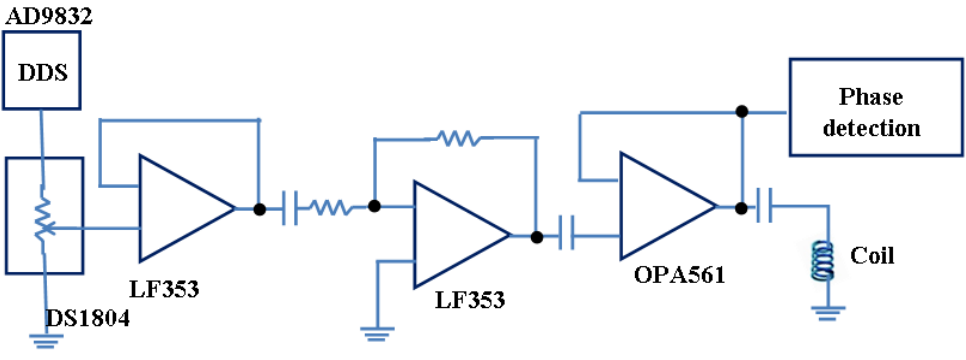
Figure 10. A schematic representation of the AC biasing circuit the block-diagram of which is shown in Figure 5. Reprinted with permission from [41].